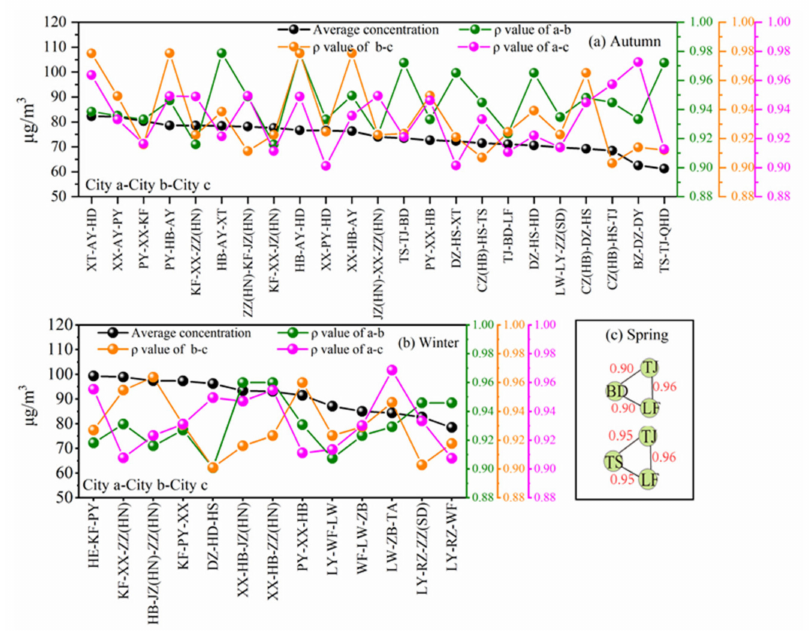
Figure 9. The city-clusters with their average PM 2.5 concentrations and ρ values for the second-level in seasons ( a ): Autumn, ( b ): Winter, ( c ):